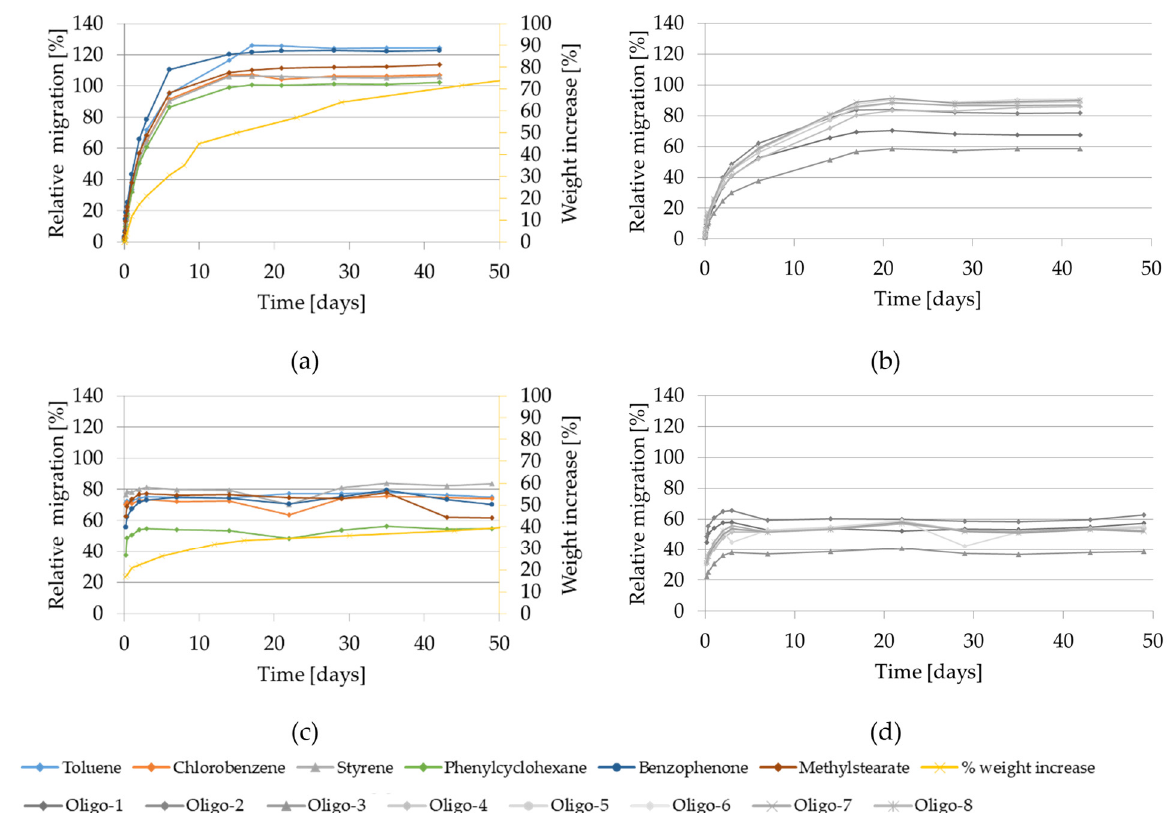
Figure 1. Migration kinetics and weight increase in isooctane at 60 °C: ( a ) Model substances and styrene from GPPS; ( b ) Styrene oligomers from GPPS. ( c ) Model substances and styrene from HIPS; ( d ) Styrene oligomers from HIPS.